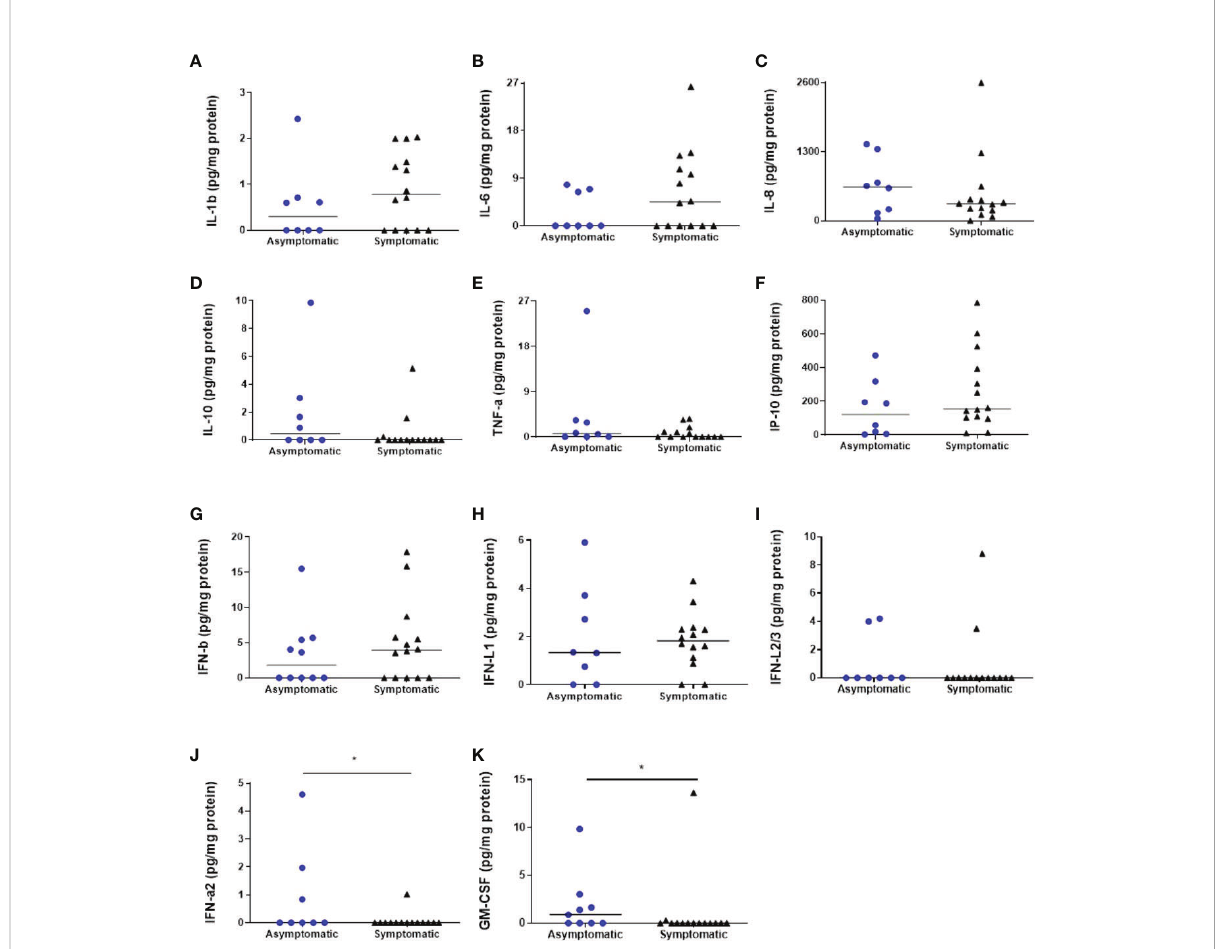
FIGURE 3 Cytokines ’ analyzes in the colostrum of symptomatic (n=14) and asymptomatic (n=8) for Covid-19 of lactating women, during pregnancy. (A) Concentration of IL-1 b (pg mg protein -1 ). (B) Concentration of IL-6 (pg mg protein -1 ). (C) Concentration of IL-8 (pg mg protein -1 ). (D) Concentration of IL-10 (pg mg protein -1 ). (E) Concentration of TNF- a (pg mg protein -1 ). (F) Concentration of IP-10 (pg mg protein -1 ). (G) Concentration of IFN- b (pg mg protein -1 ). (H) Concentration of IFN- l 1 (pg mg protein -1 ). (I) Concentration of IFN- l 2/3 (pg mg protein -1 ). (J) Concentration of IFN- a 2 (pg mg protein -1 ) (* p = 0.0423). (K) Concentration of GM-CSF (mg protein -1 ) (* p = 0.0243). Data are presented as median and 95% CI. Mann – Whitney test: p <